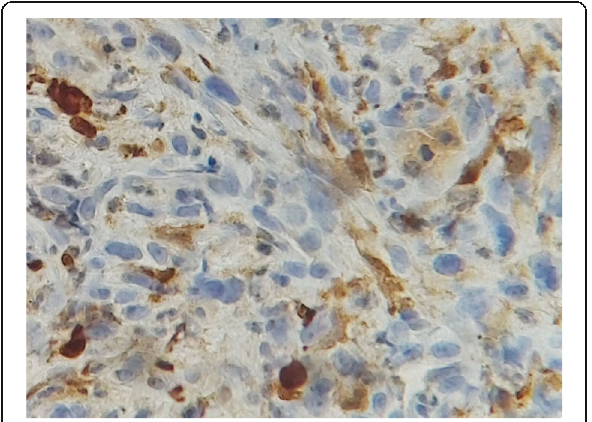
Fig. 3 Moderate partial positivity of tumor cells of PS100 (patchy)